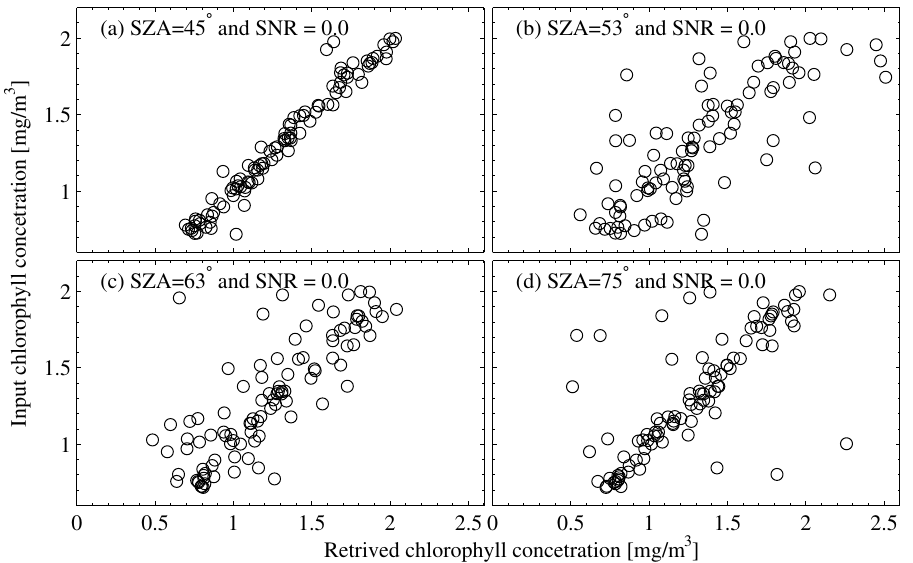
Figure 4. Comparison between input values and retrieved values for the chlorophyll concentration for different solar zenith angles (SZAs).